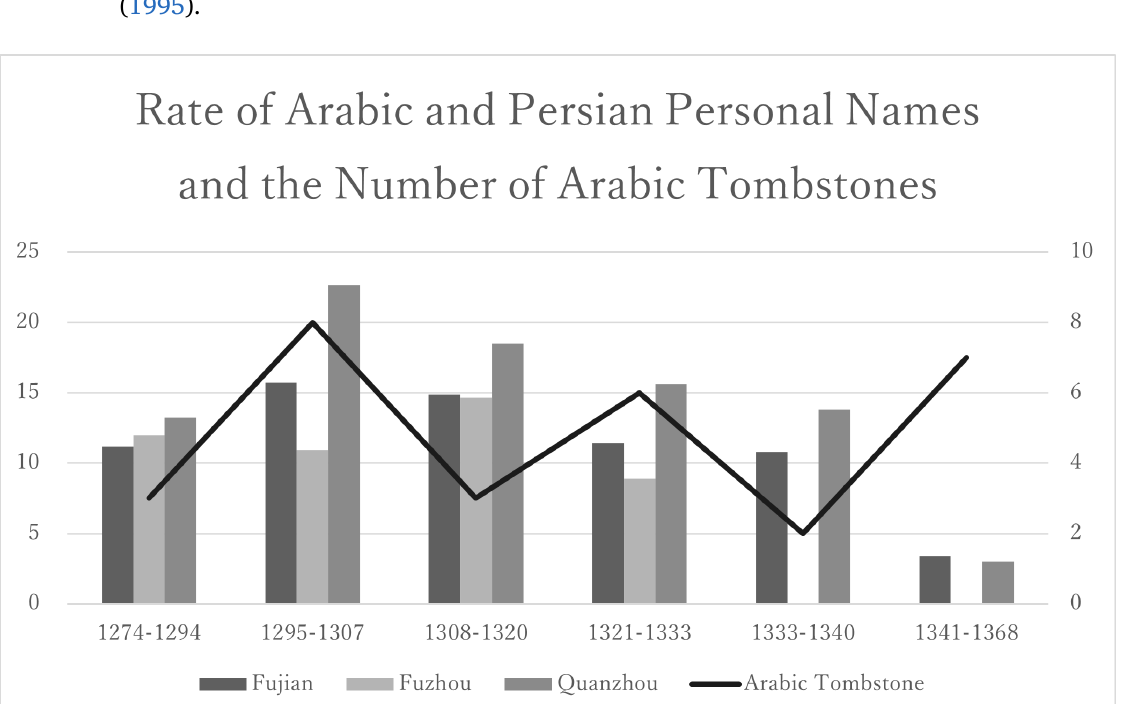
Figure 3 Occurrence of Arabic and Persian personal names of officials (histogram: the scale is on the left side) and the number of Arabic tombstones from Quanzhou (line graph: the scale is on the right side) for six terms of Yuan period. Sources: Huang ([1489] 1989) and Chen Dasheng and Kalus